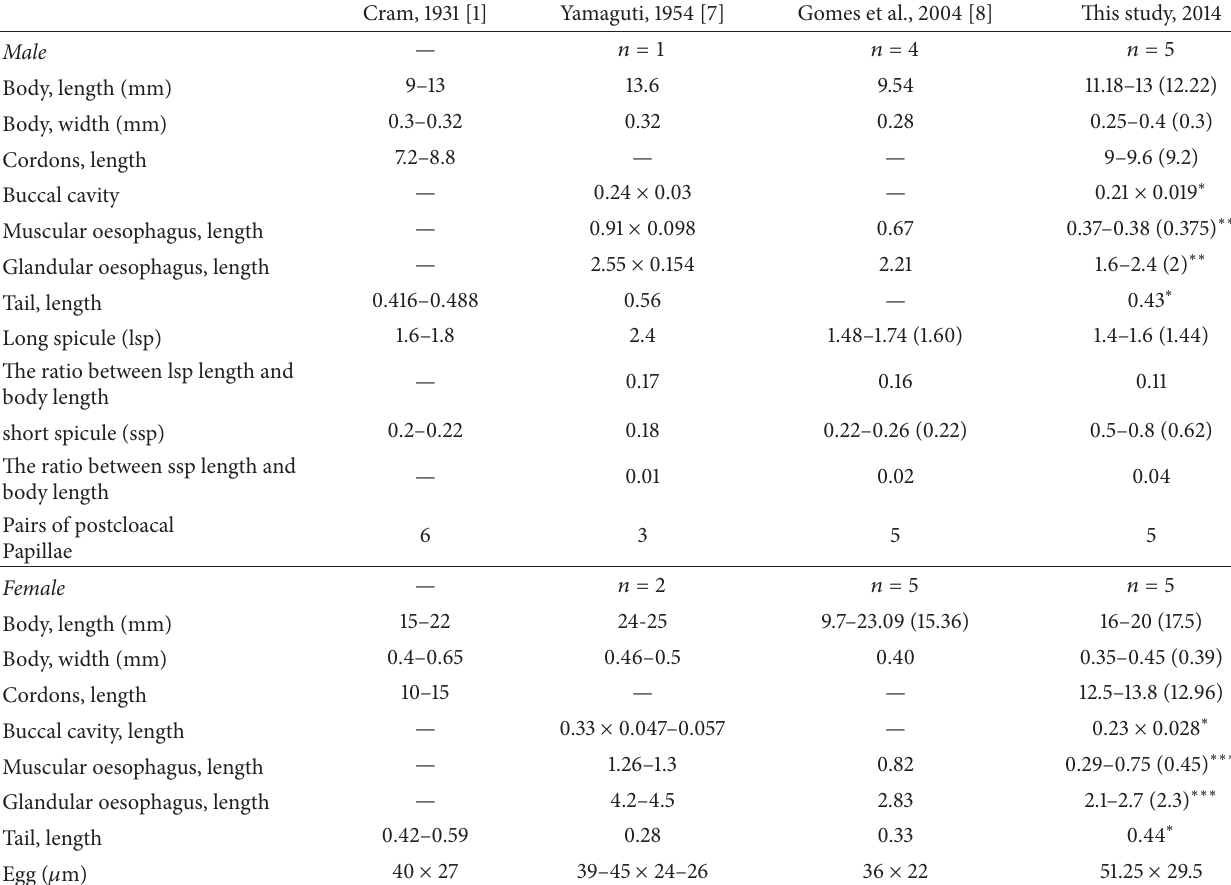
Table 1: Comparison of Cheilospirura hamulosa body parts from partridges of Iran with those of previous reports (mm).